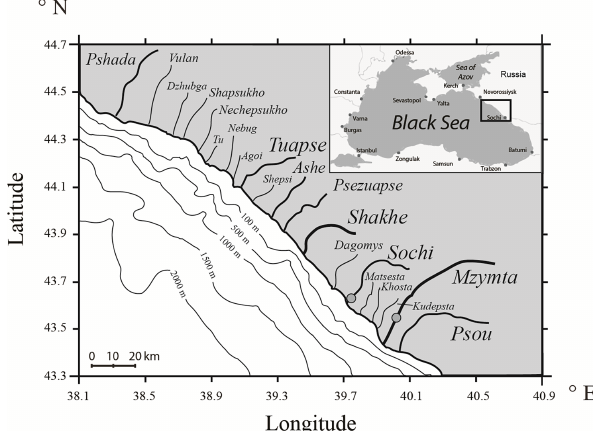
Figure 1. Location of the study region, disposition of the 20 largest rivers (thick black lines), gauge stations (gray circles at the Mzymta and Sochi rivers), and bathymetry of the coastal